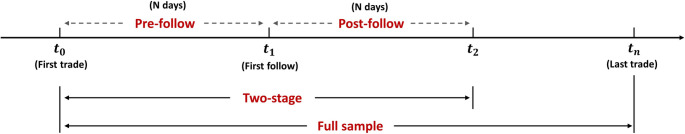
Split the sample into periods before and after social learning.